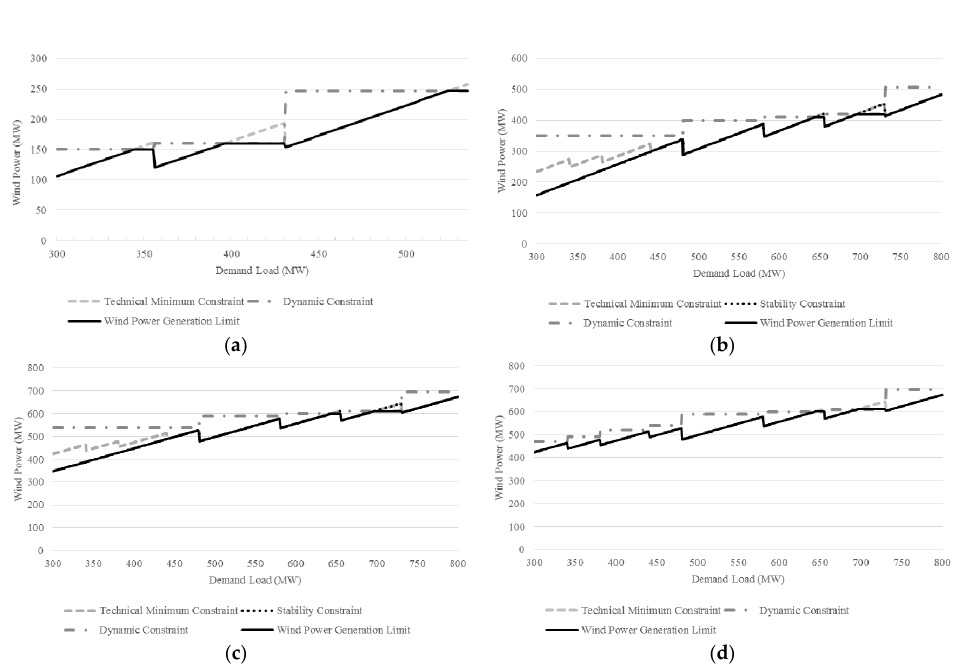
Figure 7. Maximum wind penetration in Jeju island, ( a ) w/o interconnection; ( b ) w/ unidirectional LCC HVDC; ( c ) w/ bidirectional LCC HVDC and ( d ) w/ VSC HVDC.